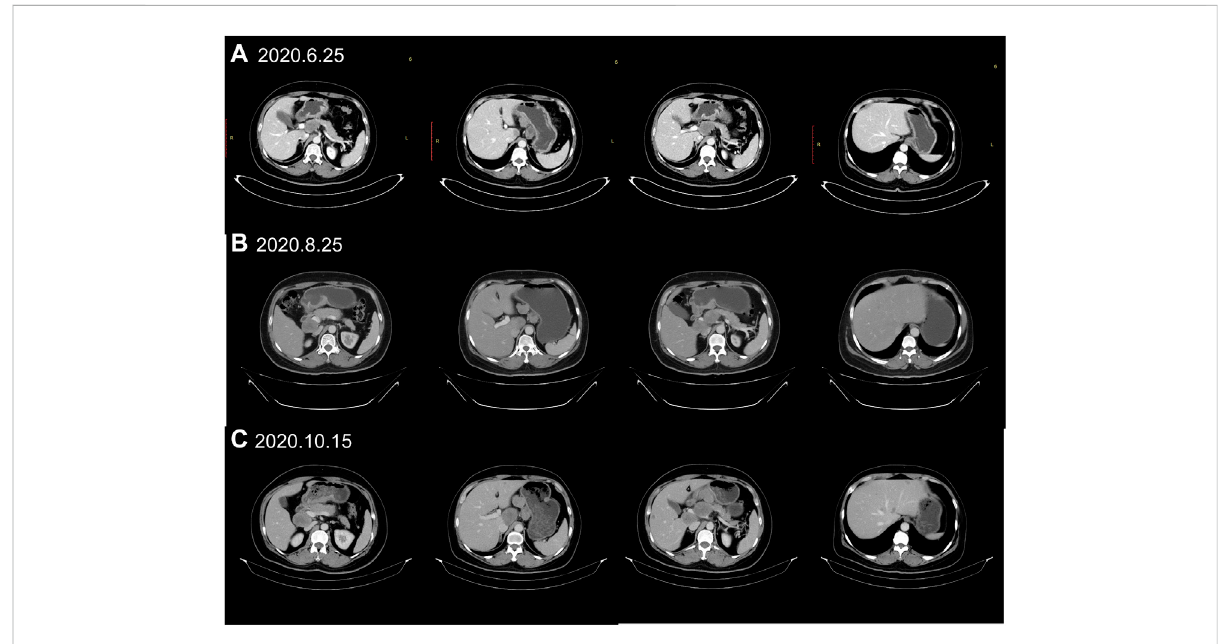
FIGURE 1 Treatment protocol before trastuzumab therapy. (A) CT scans (2020.6.25) showed the patient ’ s baseline disease; (B) CT scans (2020.8.25) demonstrated progressive disease (PD) in multiple lymph nodes metastases when fi rst-line chemotherapy failed. (C) CT scans (2020.10.15) revealed new liver metastases when the second-line chemotherapy